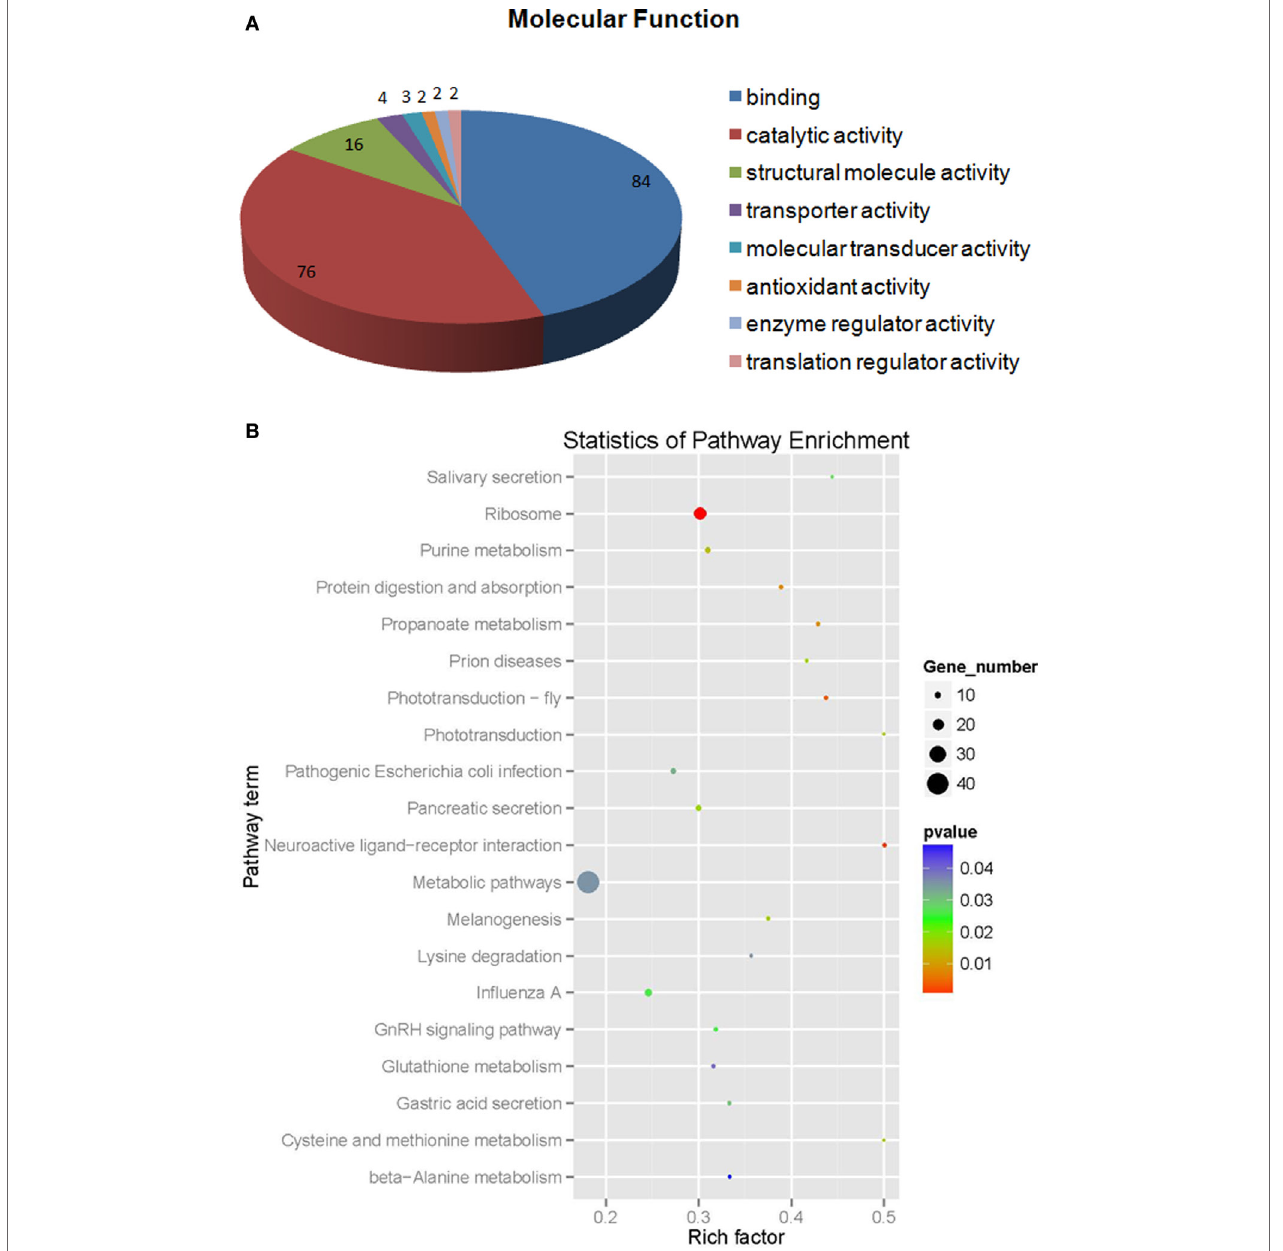
FigUre 5 | The molecular function (a) statistics for pathway enrichment (B) of differentially expressed proteins (more than 1.2-fold) from Vibrio alginolyticus vs control